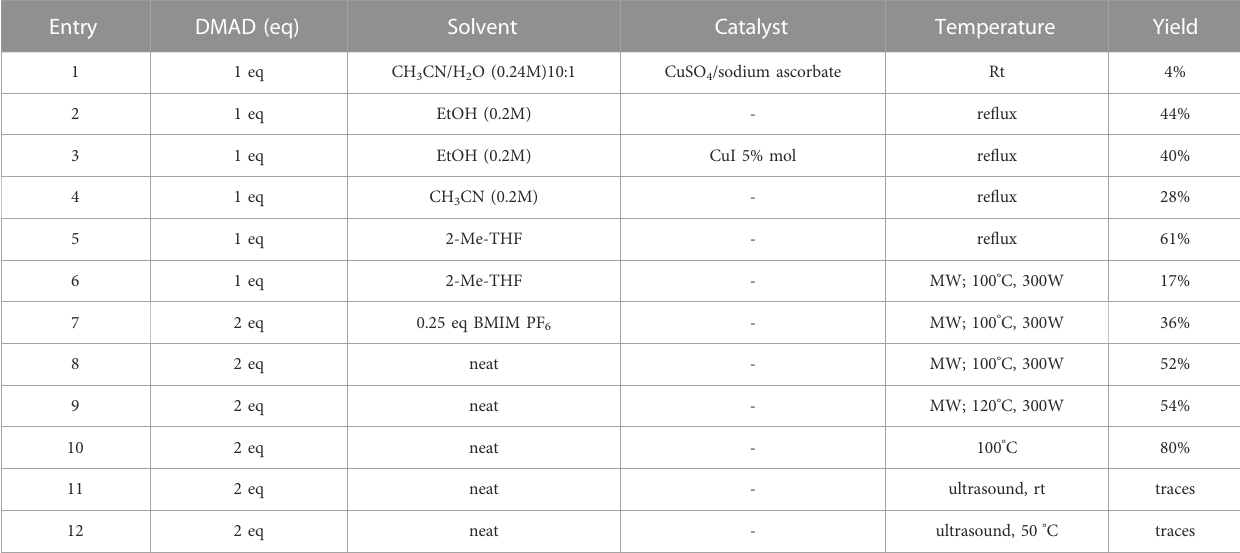
TABLE 1 Optimization of reaction conditions for triazoles synthesis.